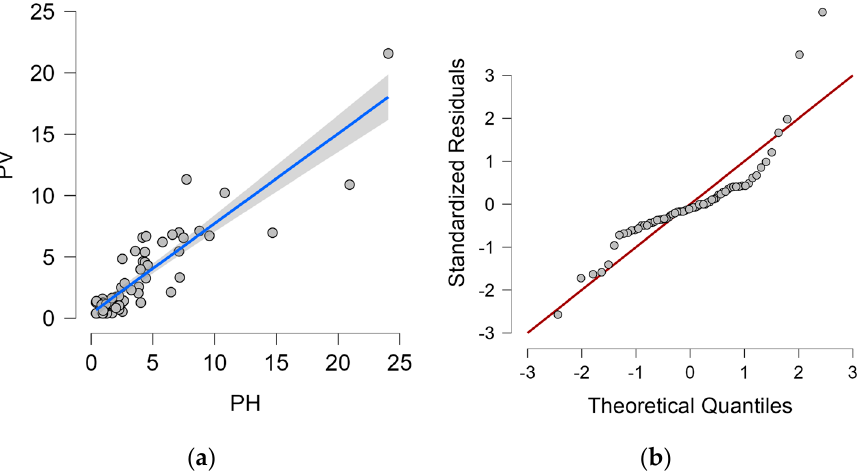
Figure 6. Horizontal dry plate method and vertical dry plate method. ( a ) Dependence of horizontal dry plate method values on and 95% confidence interval (grey area) vertical dry plate method values; ( b ) Q-Q plot.